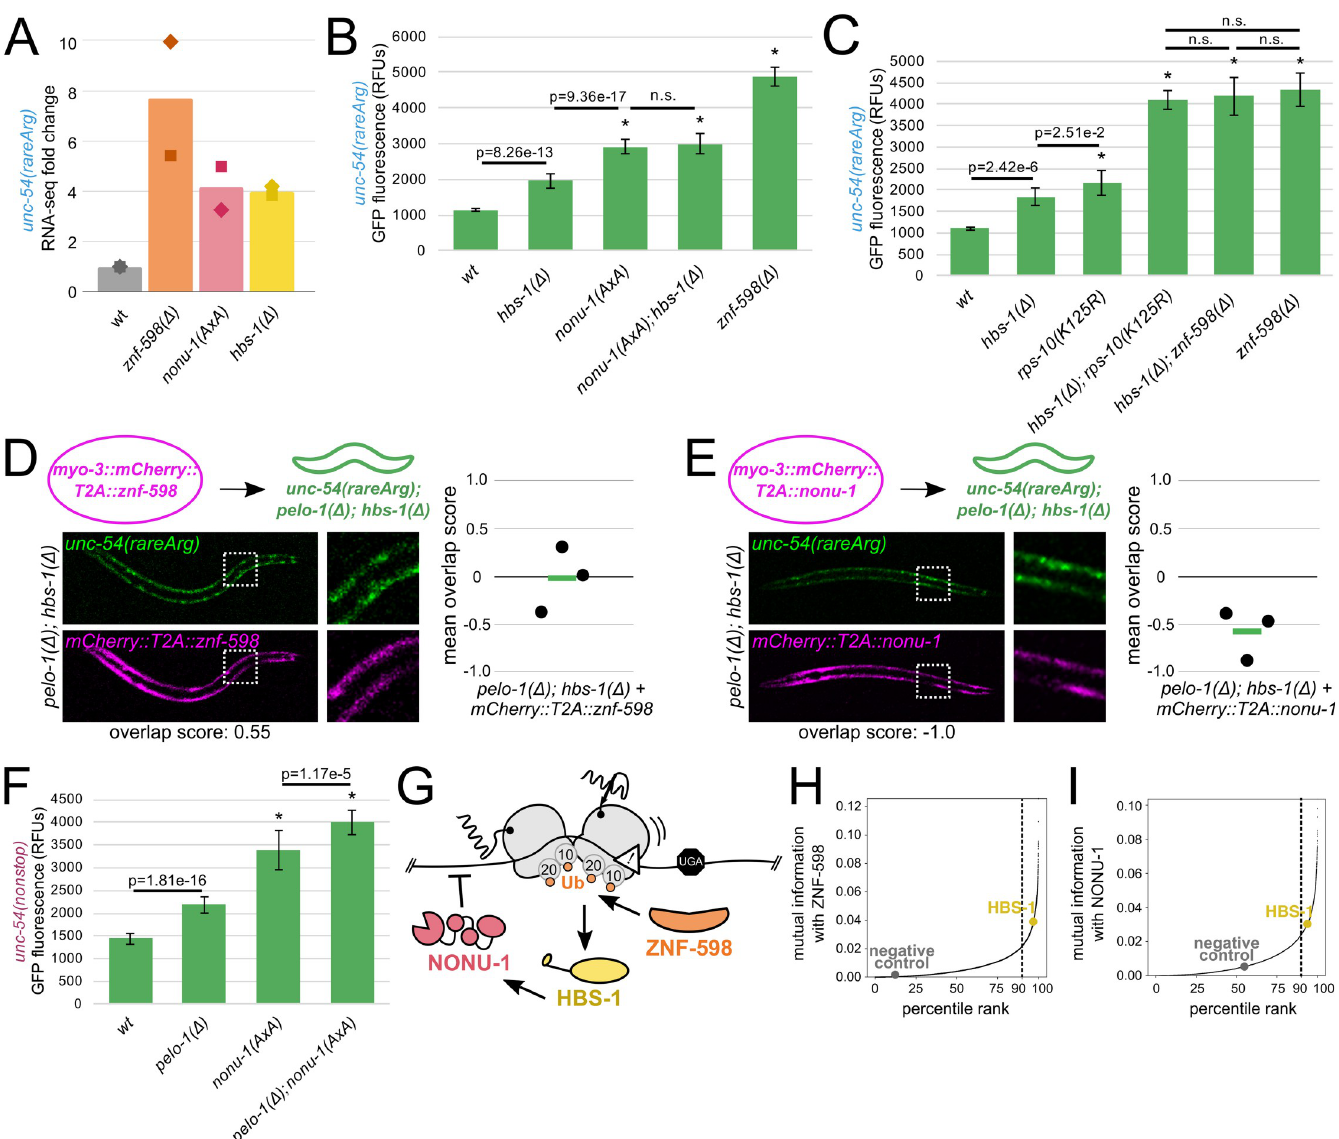
Fig 7. HBS-1 and PELO-1 are essential for mRNA degradation. (A) RNA-seq mean fold change of unc-54(rareArg) in the indicated strains from two biological replicates (shown as diamonds and squares). (B, C) Mean RFUs (relative fluorescence units) of indicated strains (n � 15 animals/strain) in the unc-54(rareArg) background. One standard deviation shown as error bars. p values from Welch’s t-test, with asterisks indicating p < 0.01 for all comparisons with wild type. (D) As in Fig 2, with znf-598 construct in pelo-1; hbs-1 strain. (E) As in Fig 2, with nonu-1 construct in pelo-1; hbs-1 strain. (F) Mean RFUs (relative fluorescence units) of indicated strains (n � 15 animals/strain) in the unc-54(nonstop) background. One standard deviation shown as error bars. p values from Welch’s t-test, with asterisks indicating p < 0.01 for all comparisons with wild type. (G) Model for NGD via ZNF-598, HBS-1, and NONU-1. (H) ZNF-598 mutual information plot. 90% percentile cutoff is shown as a dashed line, HBS-1 is highlighted in yellow, and a negative control protein is highlighted in gray. (I) As in (H), showing NONU-1 mutual information with